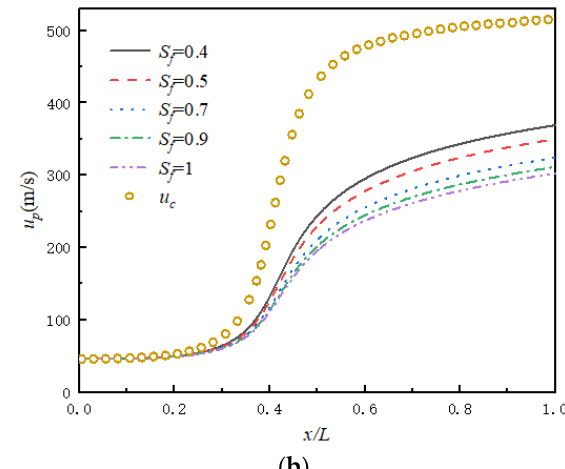
Table 2. The sphericity of several regular-shaped particles.